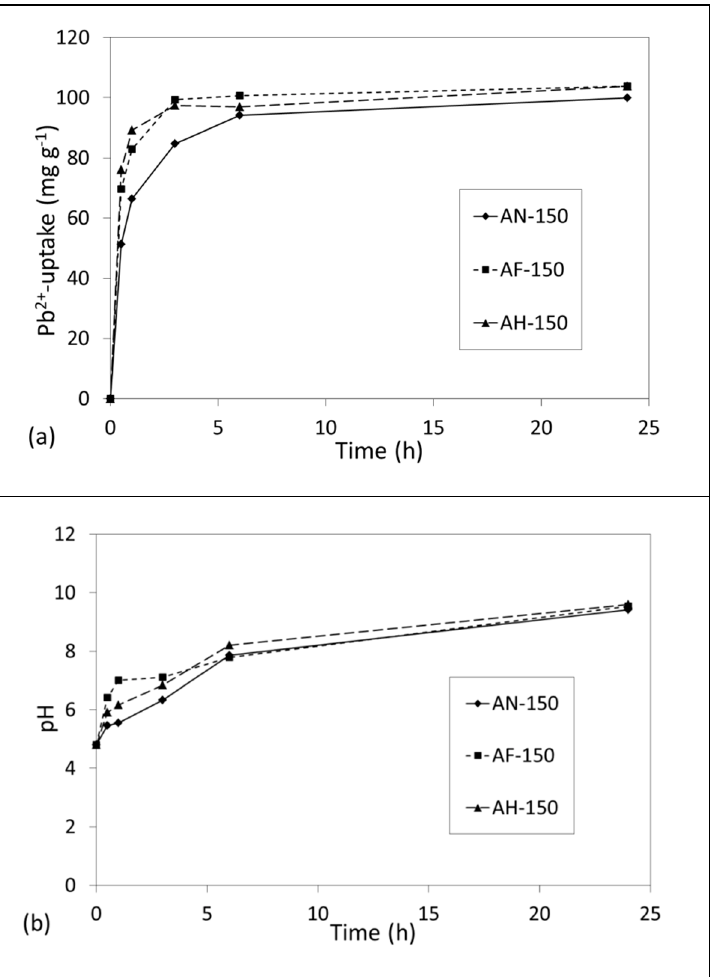
Figure 8. ( a ) Removal of Pb 2+ ions by hydrothermal products AN-150, AF-150 and AH-150 and ( b ) corresponding pH values of the supernatant liquors. Equilibrium removal of Cd 2+ ions by AN-150 (36 mg g − 1 , 0.32 mmol g − 1 ) was